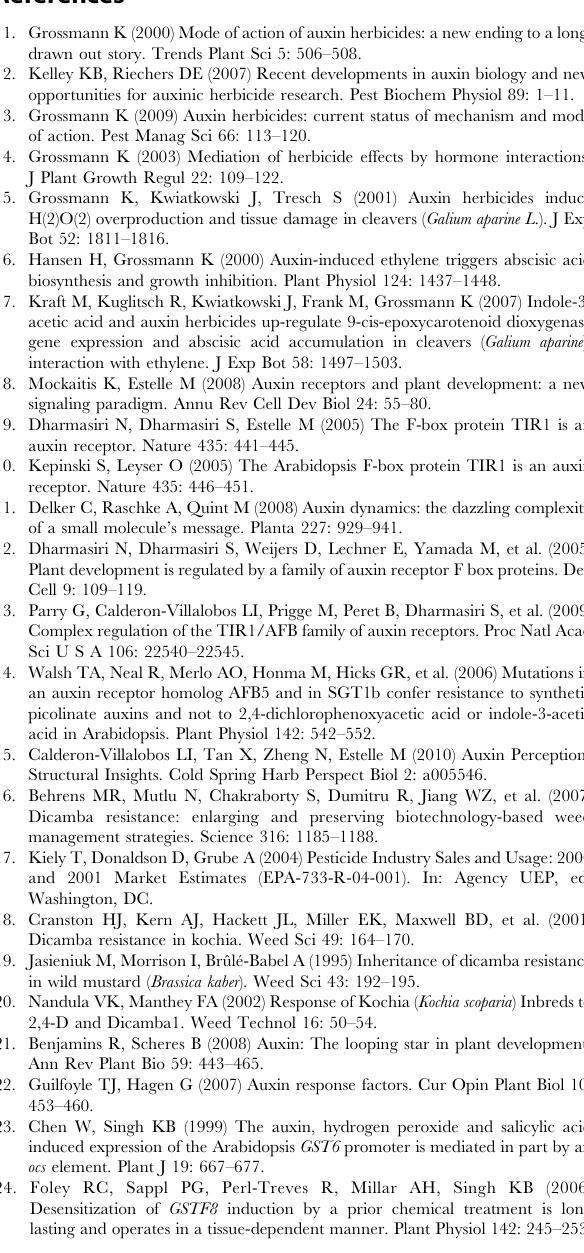
Table S3 Primers used in